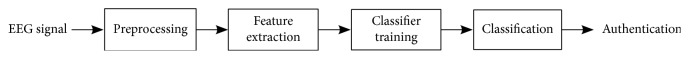
General framework of a biometric authentication system.